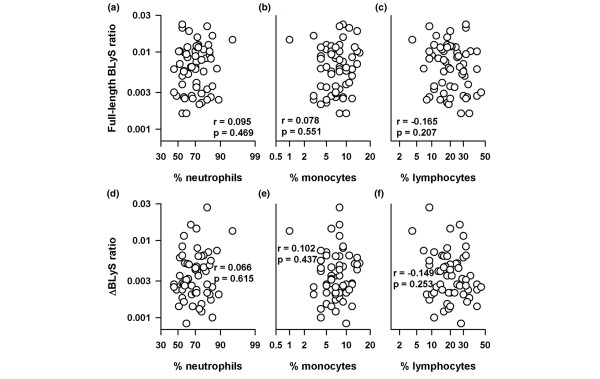
No correlation in SLE between BLyS mRNA isoforms and percentages of individual leukocyte cell types. Individual (a–c) full-length BLyS mRNA levels and (d–f) ΔBLyS mRNA levels are plotted against corresponding peripheral blood percentages of neutrophils (a,d), monocytes (b,e), and lymphocytes (c,f). BLyS, B lymphocyte stimulator.